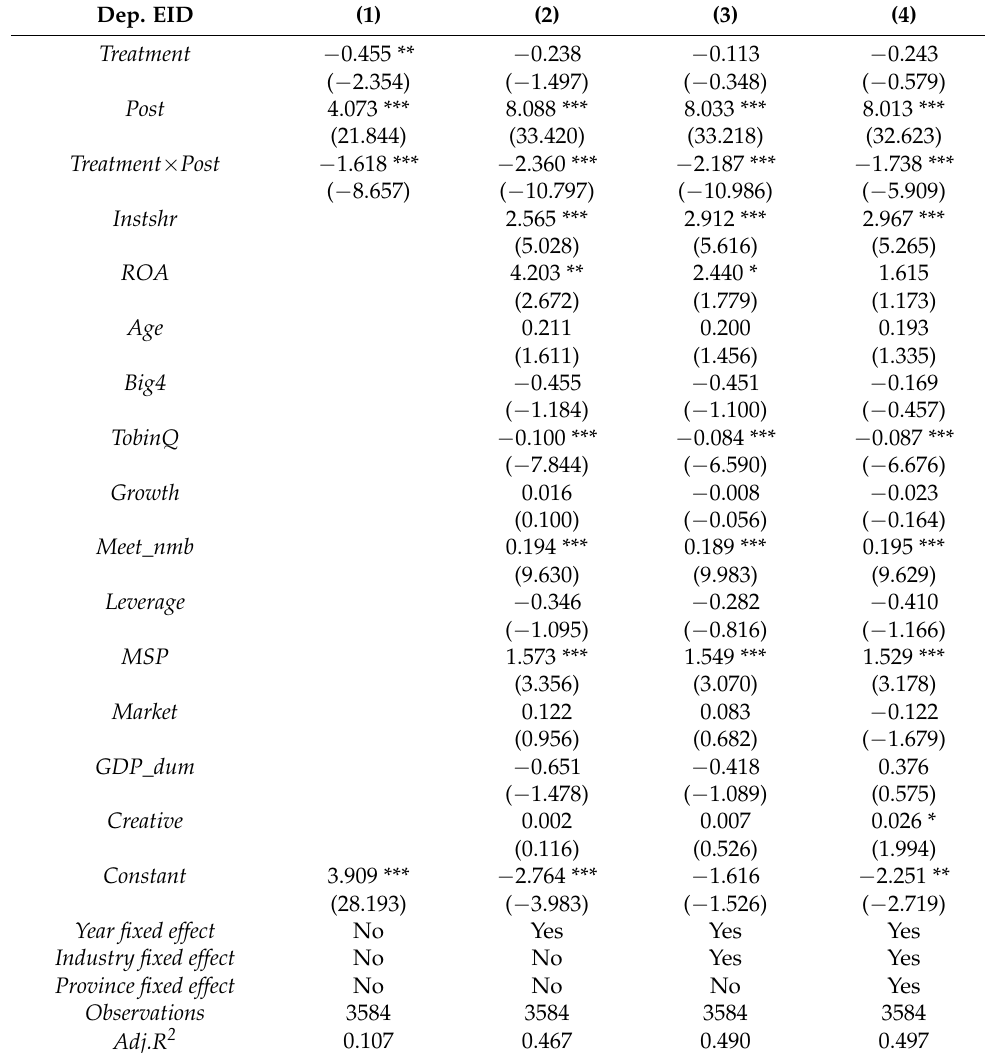
Table 9. DID regression results for the impact of COVID-19 on analyst site visits and CEID in Wuhan and other cities in